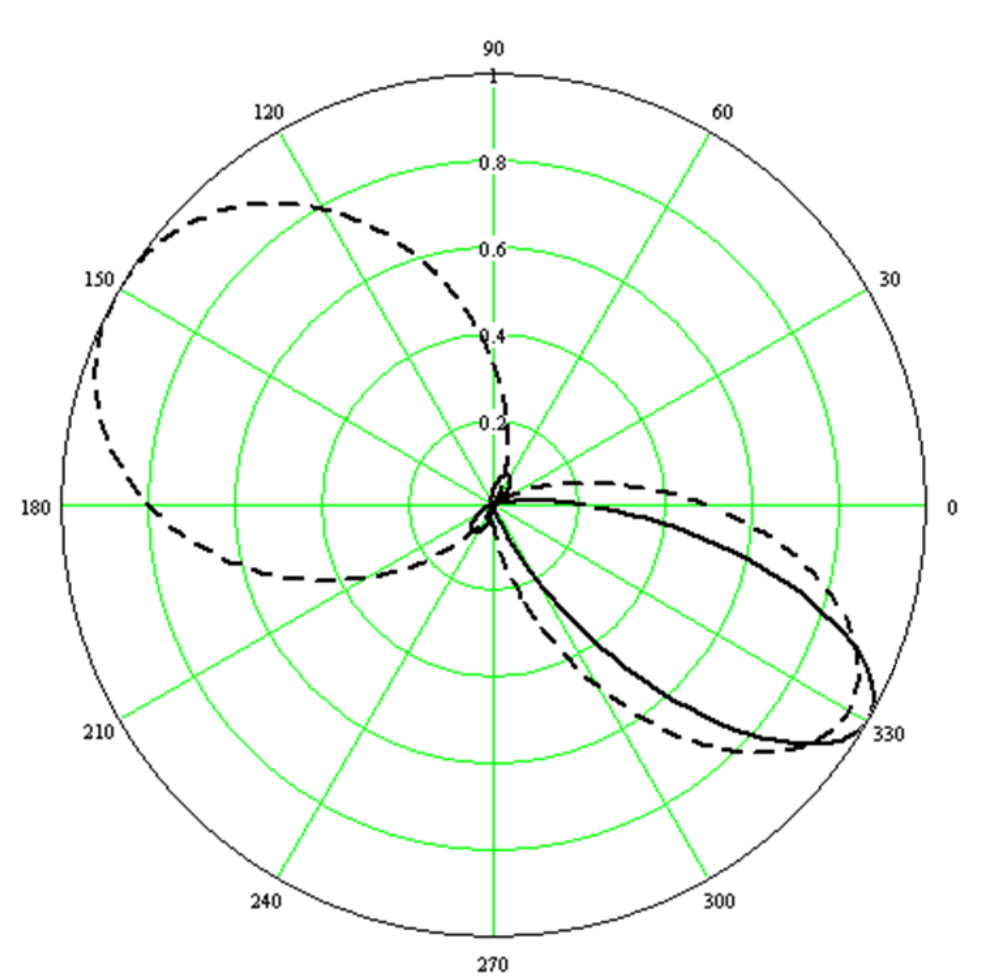
Figure 18. The radiation patterns of RAA (dashed line) and VAA (solid line) at a frequency of f = 62 MHz.